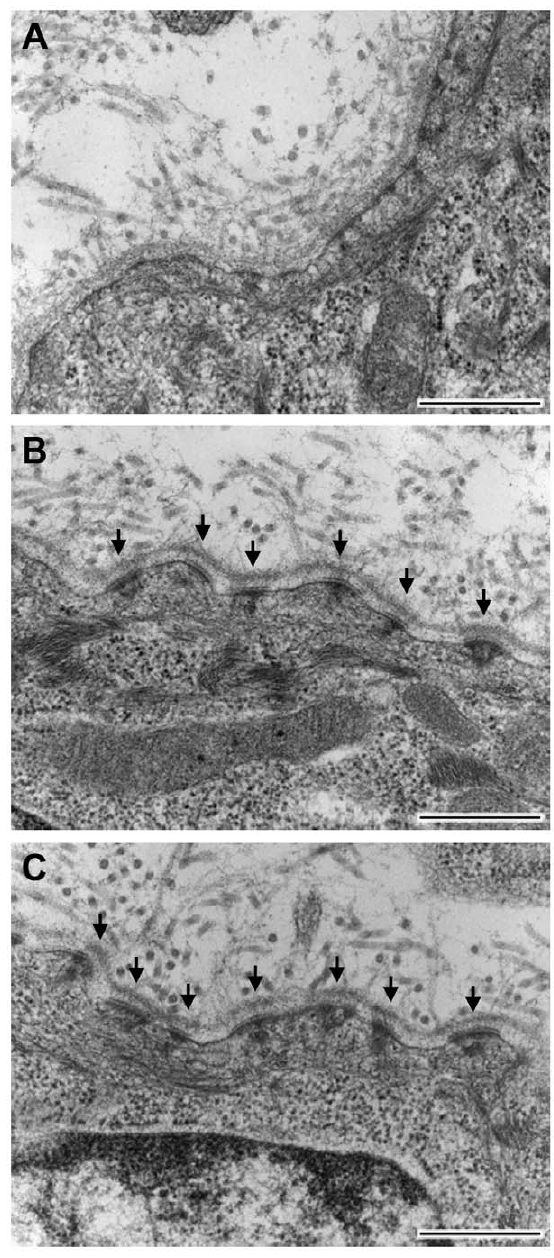
Figure 10. Expression of human laminin c 2 facilitates assembly of hemidesmosomes in rescued Lamc2 KO mice. Transmission electron microscopic images of newborn skin of Lamc2 KO (A), rescued Lamc2 KO (B), and Lamc2 WT (C) mice are shown. Hemidesmosomes of newborn Lamc2 KO skin are poorly formed, devoid of lamina densa and anchoring filaments, and containing few anchoring fibrils (A). In contrast, rescued Lamc2 KO (B) and Lamc2 WT (C) mice had well- organized hemidesmosomes with electron dense plaques, anchoring filaments, anchoring fibrils, and darkened areas of lamina densa abutting the hemidesmosomes (arrows). All images are of the same magnification. Bar represents 500 nm. doi:10.1371/journal.pone.0045546.g010 laminin c 2 of Lamc2 WT mice (Figure 3C). Furthermore, the